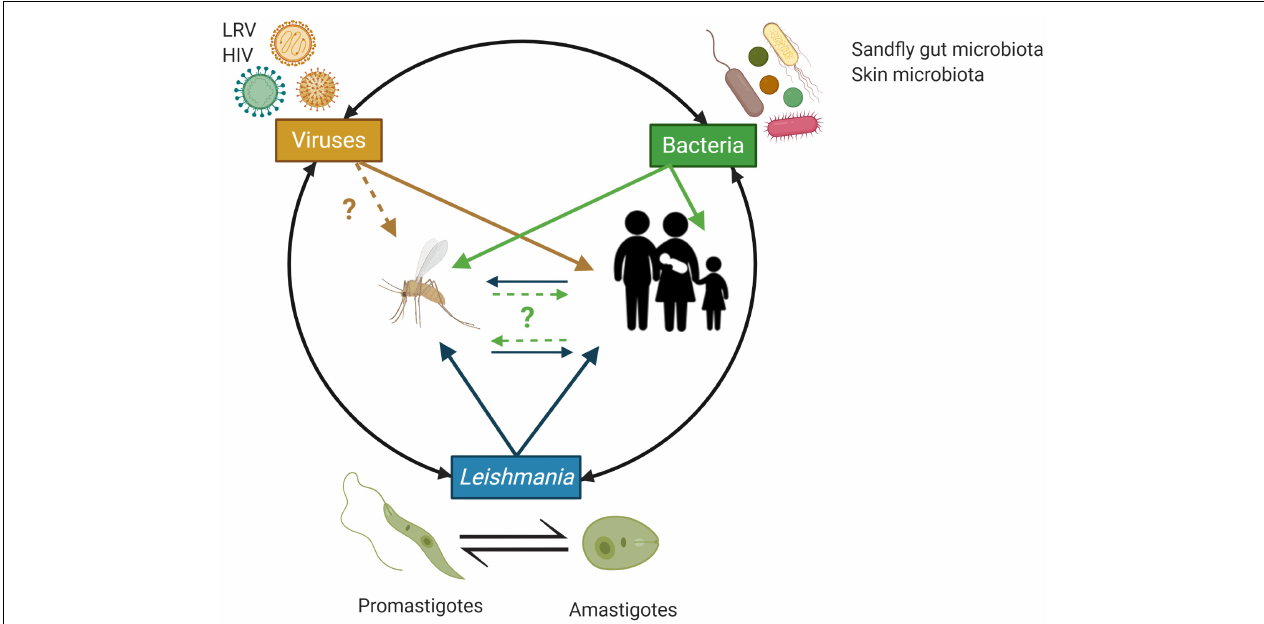
FIGURE 2 | Schematic overview of the potential trans-kingdom cross talk between Leishmania , viruses (including Leishmania RNA virus – LRV) and bacteria from the implicated animal hosts microbiota and their impact on the human host. Animal hosts (here, sand flies and humans) are increasingly recognized to be supra-organisms made of animal cells/tissues/organs and their associated microbiota (e.g., associated with the human skin and mucosal surfaces) that through complex, continuous and highly dynamic interactions contribute to the host phenotype in both health and disease. In the context of infections by Leishmania , initiated by the bite of a sand fly, bacteria from the insect gut microbiota, the human skin microbiota and Leishmania RNA virus (LRV), which can infect Leishmania , have all be implicated in regulating the inflammatory tone associated with the infection by Leishmania and by doing so to the various pathobiologies associated with Leishmania infections. HIV is also indicated as AIDS can facilitate/worsen the pathobiology or Leishmania infections through weakening the host immune response and represent an important case of co-infections with negative impact on the human host. Image created with